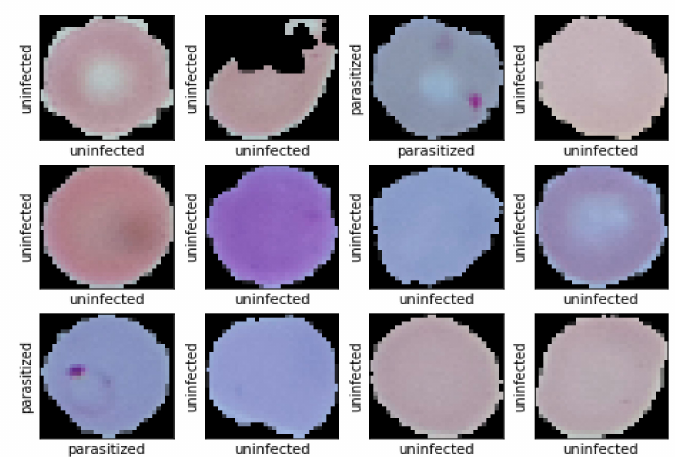
Figure 12. Some predicted result of Autoencoder based model. Here X-axis represents Ground Truth value and Y-axis represents model prediction.